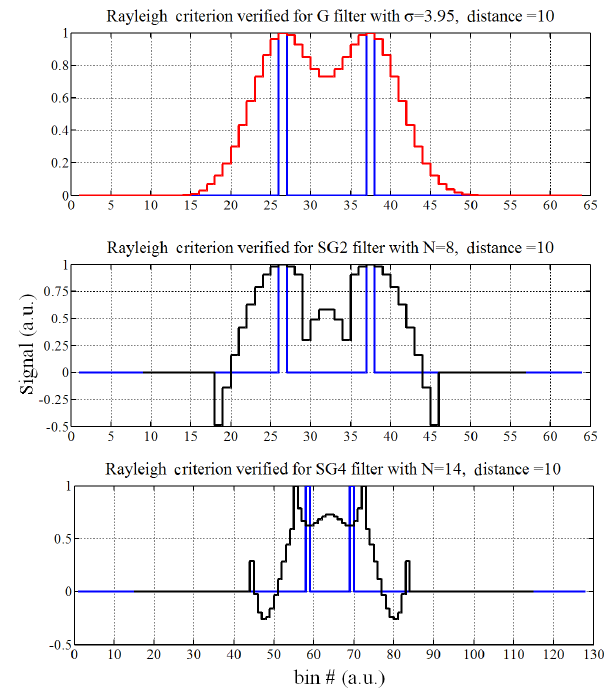
Figure 7. The Rayleigh criterion applied to a couple of one bin thick ( (cid:49)R raw = 1, in arbitrary units, a.u.) unitary pulses (blue line) distant 10 bins. The lower and central panels show (black lines) the smoothed profile obtained using the SG filters: unwanted fea- tures (under-shots, the central “bump” and the displacement of the smoothed peaks) are quite evident in both cases. The profile ob- tained with the Gaussian filter (upper panel, red line) has no prob- lems. All smoothed profiles are normalized to the maximum.